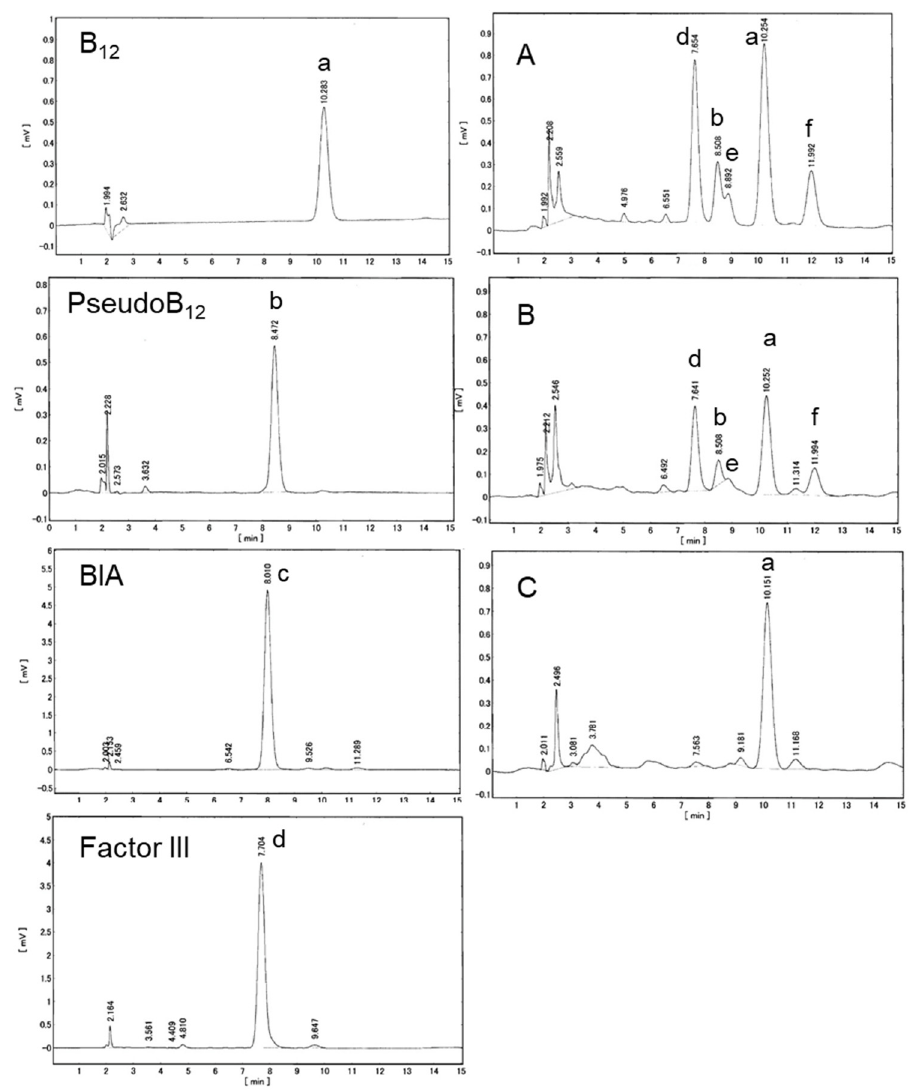
Figure 2. HPLC chromatograms for selected fermented poultry manure fertilizer products. A, B, and C represent the products listed in Table 1. a, b, c, and d represent peaks with the identical retention times of B 12 , PseudoB 12 , BIA, and Factor III, respectively. e and f represent unidentified compounds. Typical HPLC data are obtained from three independent experiments.